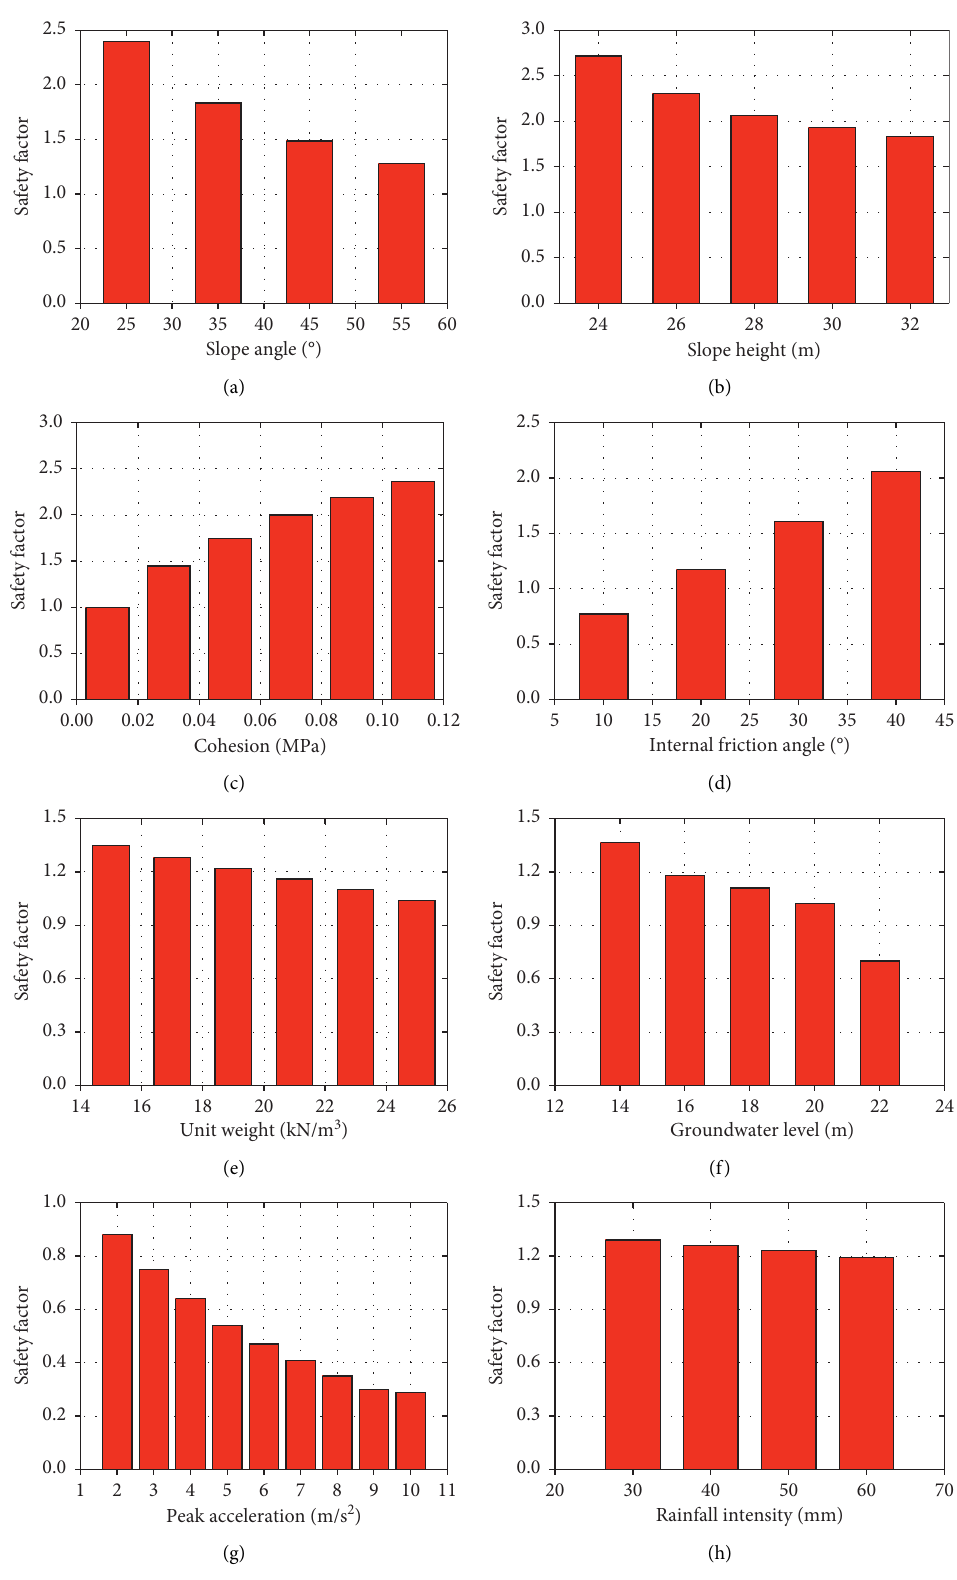
Figure 5: Safety factors under different influencing factors. (a) Slope angle. (b) Slope height. (c) Cohesion. (d) Internal friction angle. (e) Unit weight. (f) Groundwater level. (g) Peak acceleration. (h) Rainfall